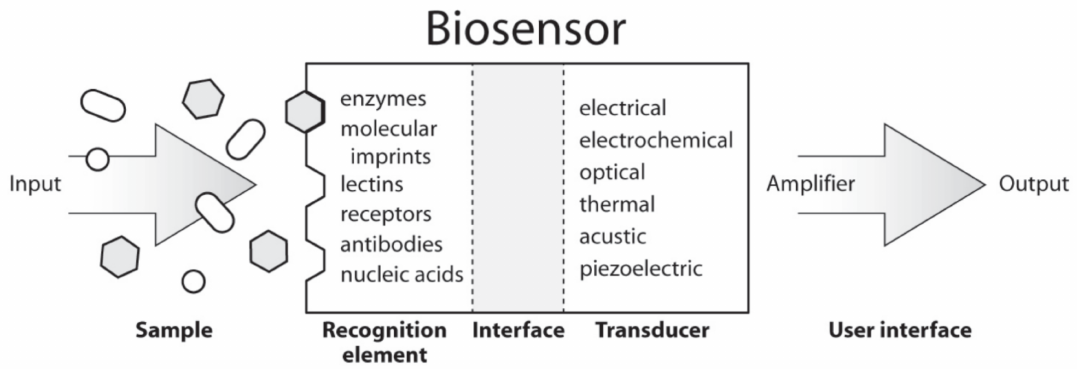
Figure 15. Configuration of a biosensor showing biorecognition, interface, and transduction elements. Reprinted by permission from